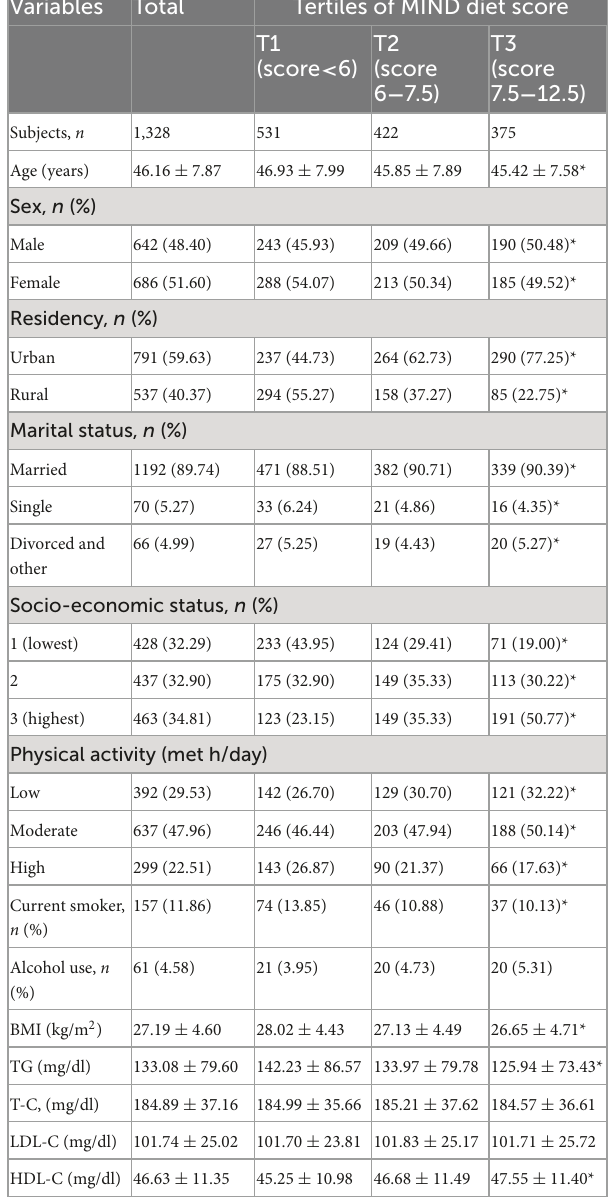
TABLE 2 General characteristics of the participants in the study based on tertiles (T) of MIND. Variables